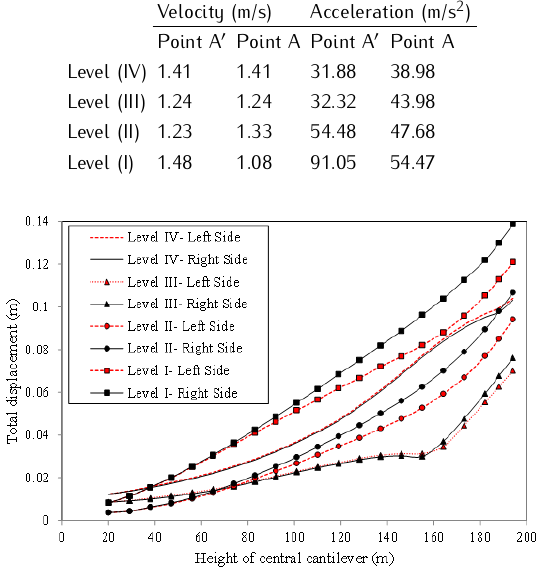
Figure 15. Non-concurrent envelope of displacement along the height of the crown cantilever; NL-DCM